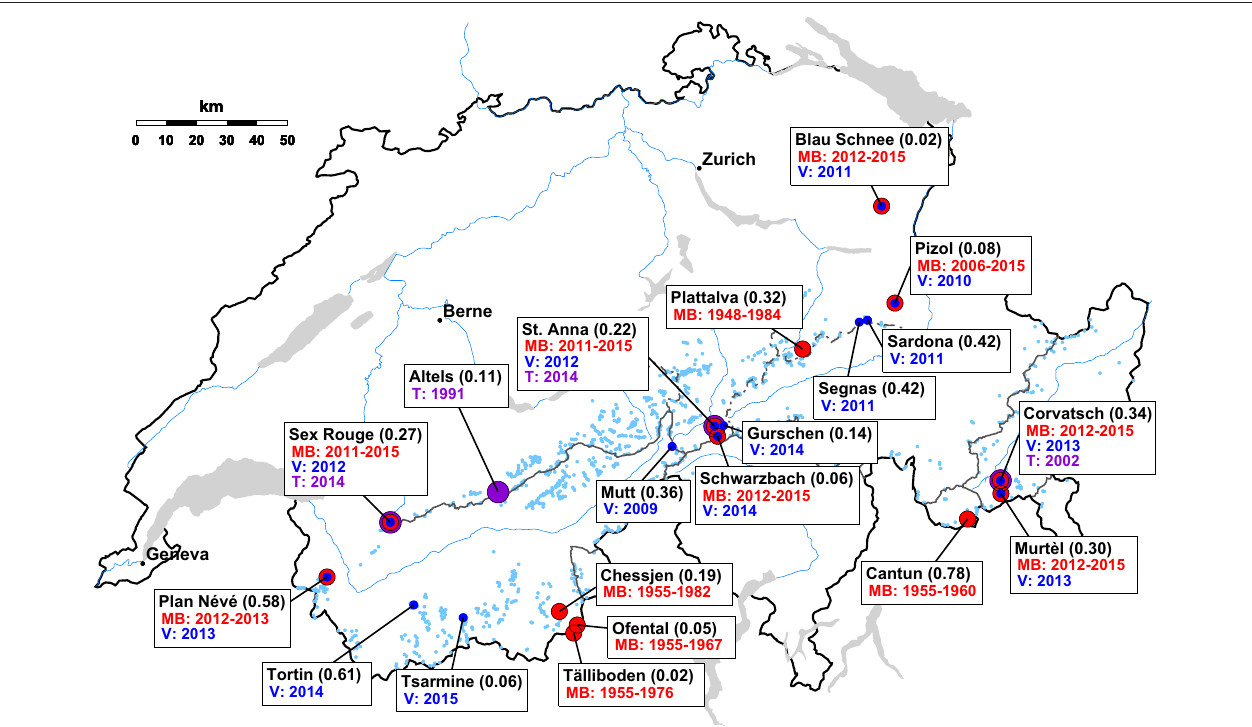
FIGURE 3 | Availability of different types of data on very small glaciers in the Swiss Alps. (1) surface mass balance (MB, red), (2) ice volume (V, blue), and (3) englacial temperature (T, purple). Glacier area (year 2010) in km 2 is stated in brackets.